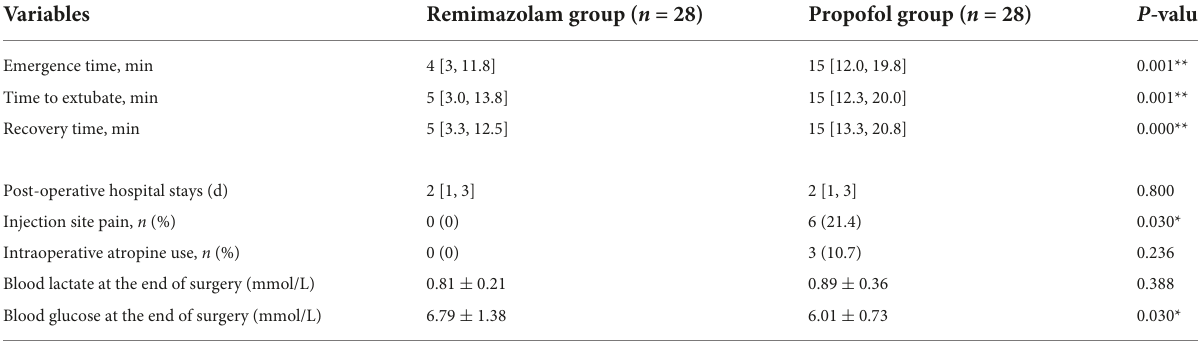
TABLE 3 Clinical recovery variables and complications.